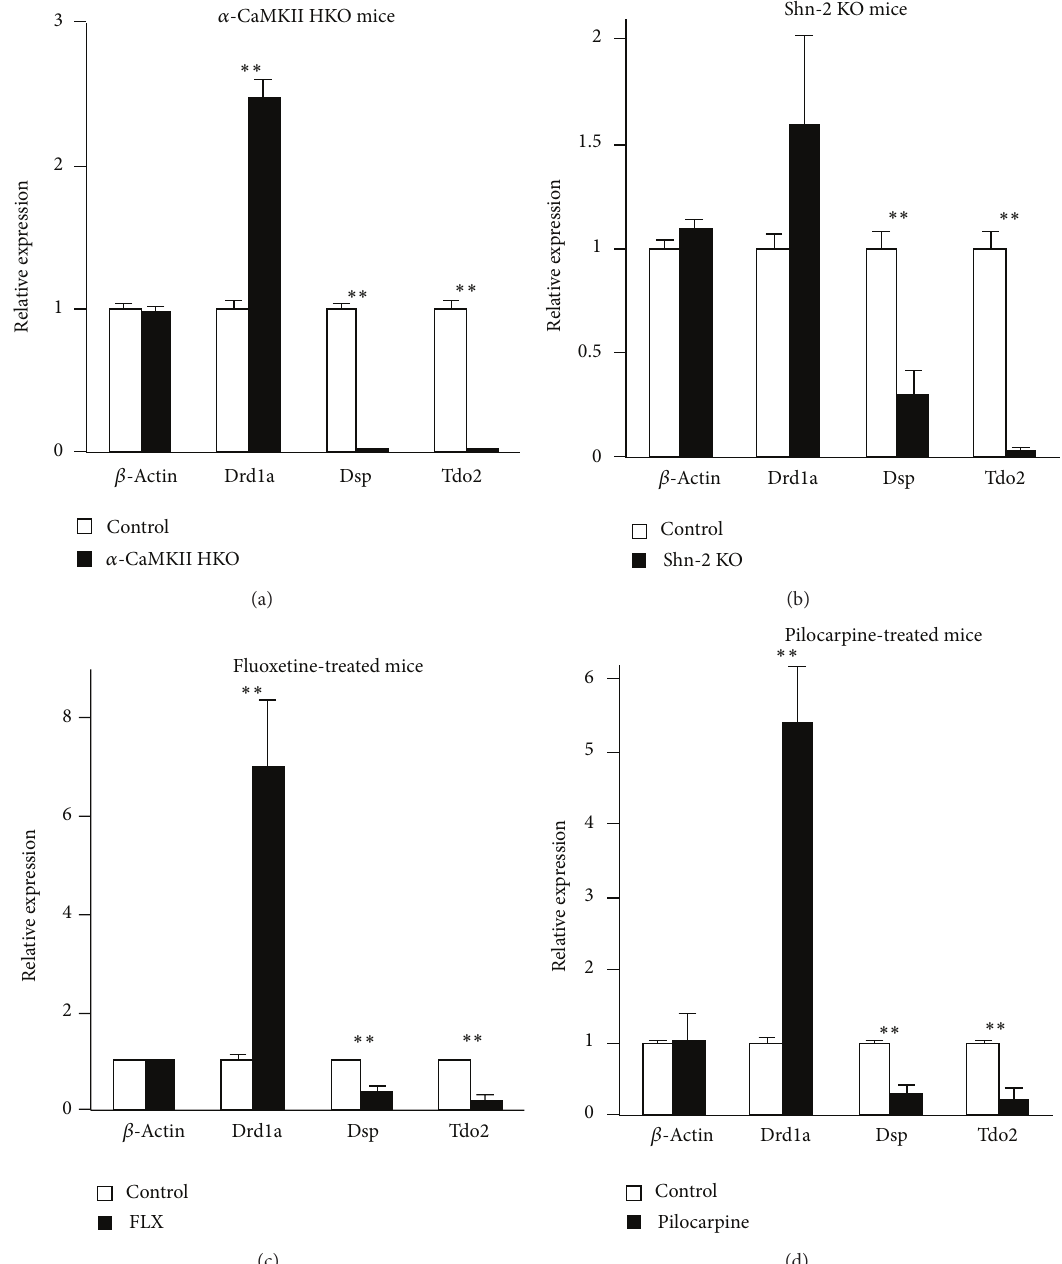
Figure 5: Identification of the iDG phenotype using real-time polymerase chain reaction. iDG is characterized by upregulation of dopamine receptor D1a ( Drd1a ) and downregulation of both desmoplakin ( Dsp ) and tryptophan 2,3-dioxygenase ( Tdo2 ) in the hippocampus. Asterisks indicate statistical significance determined using the Student’s 𝑡 -test ( ∗∗ 𝑃 < 0.01 , 𝑛 = 4 –7 per group). Adapted from Yamasaki et al. [1], Takao et al. [2], Kobayashi et al. [5], and Shin et al.